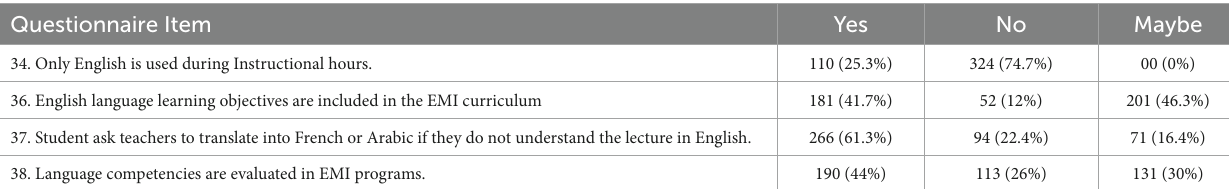
TABLE 5 Current practices of